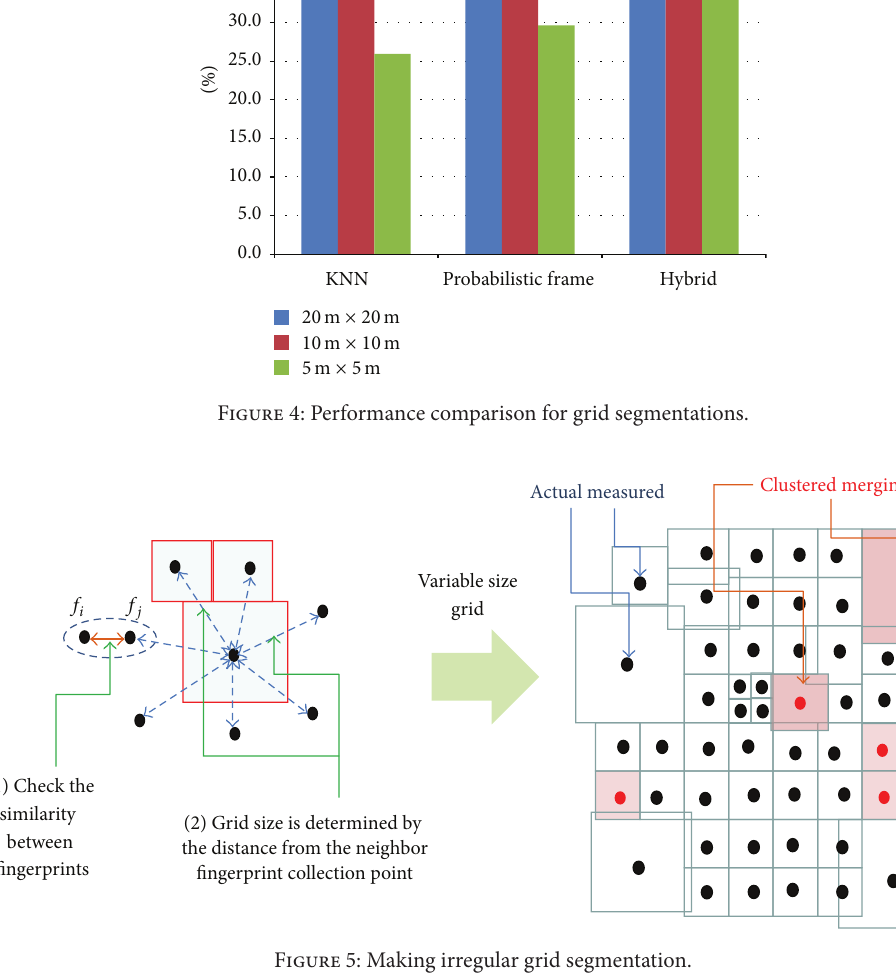
Figure 5: Making irregular grid